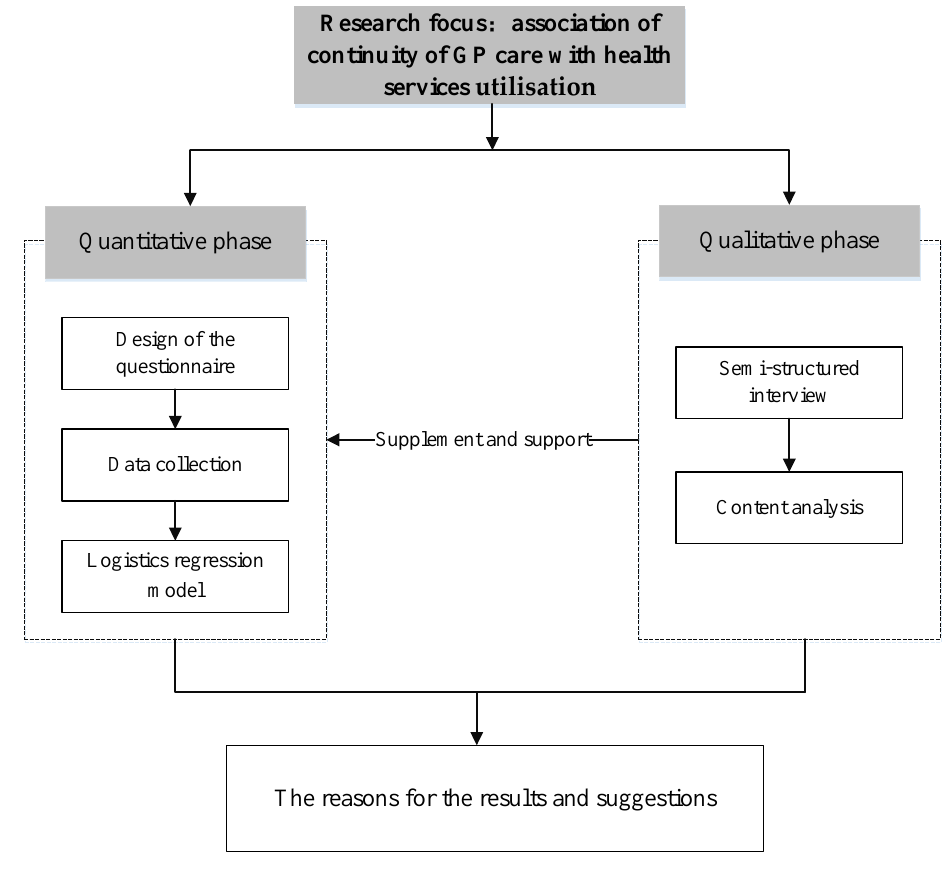
Figure 1. Process of mixed methods research.